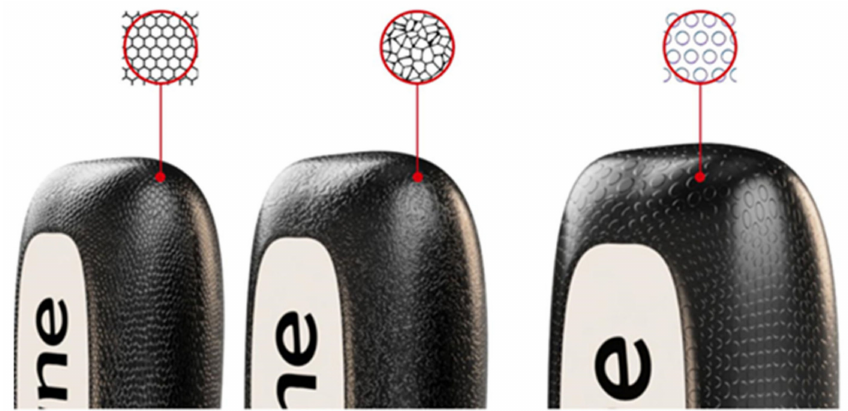
Figure 10. Patterns of tactile customization of the handle: a honeycomb, a broken glass shape, and